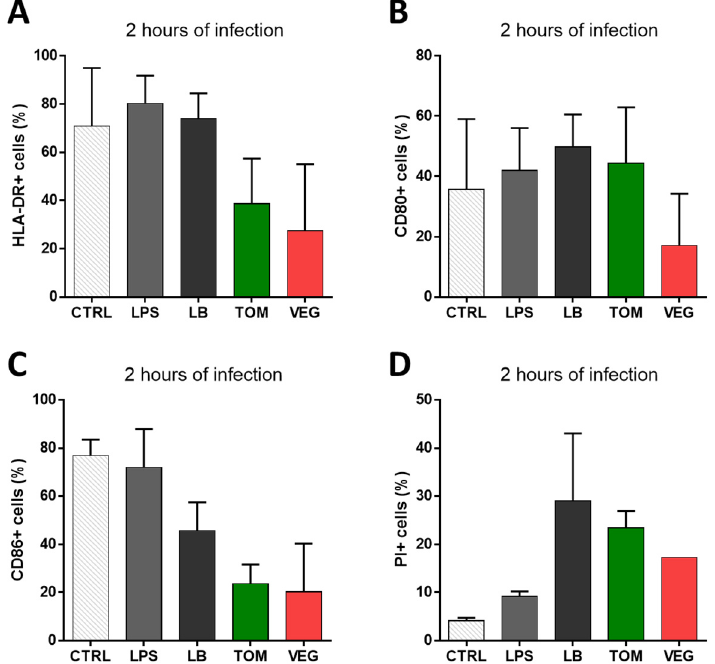
Figure 4. Activation and viability profile of mDCs after in vitro infection with E. coli analyzed by flow cytometry. Histograms represent the percentage of mDCs cells positive for ( A ) HLA-DR, ( B ) CD80, ( C ) CD86, and ( D ) propidium iodide (PI) after being cultured under different conditions: without any stimulus (control, CTRL), in the presence of only LPS (LPS), with E. coli LB (LB), with E. coli TOM (TOM), or with non-contaminated tomato (VEG). Data were analyzed using GraphPad Prism v.6 software, with one-way ANOVA test followed by Tukey’s post hoc test for multiple comparisons. Error bars represent the standard error of the mean.